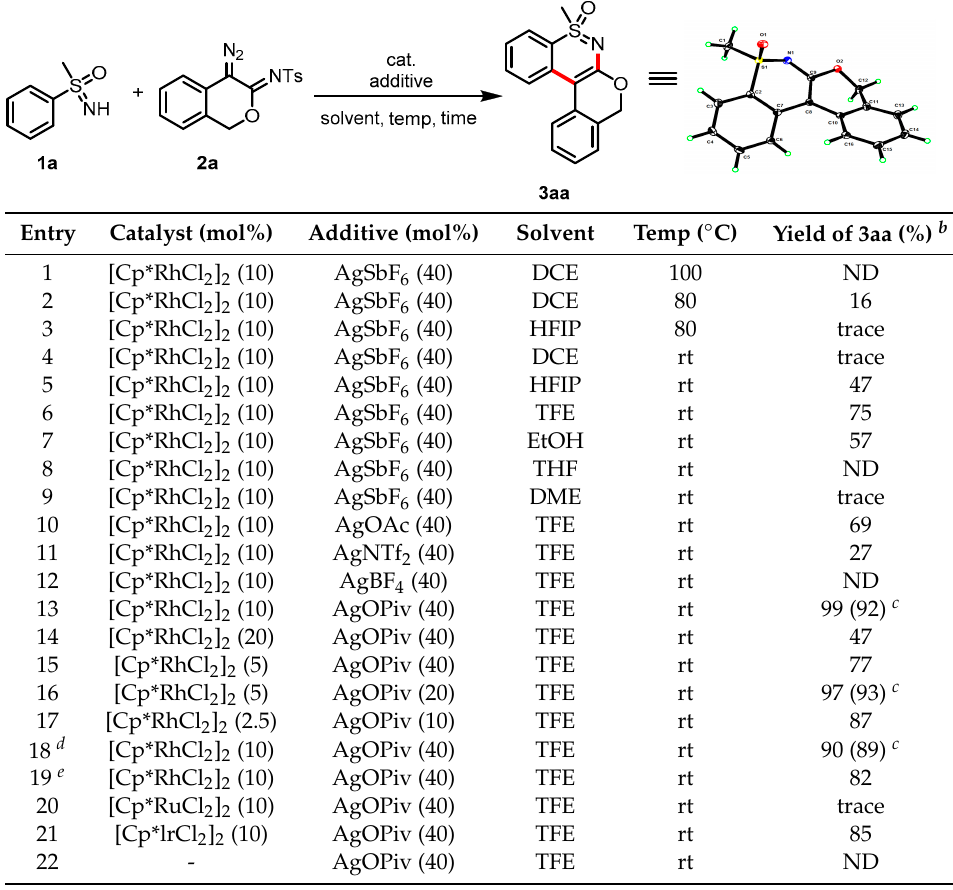
Table 1. Optimization of reaction conditions a . TFE: trifluoroethanol.